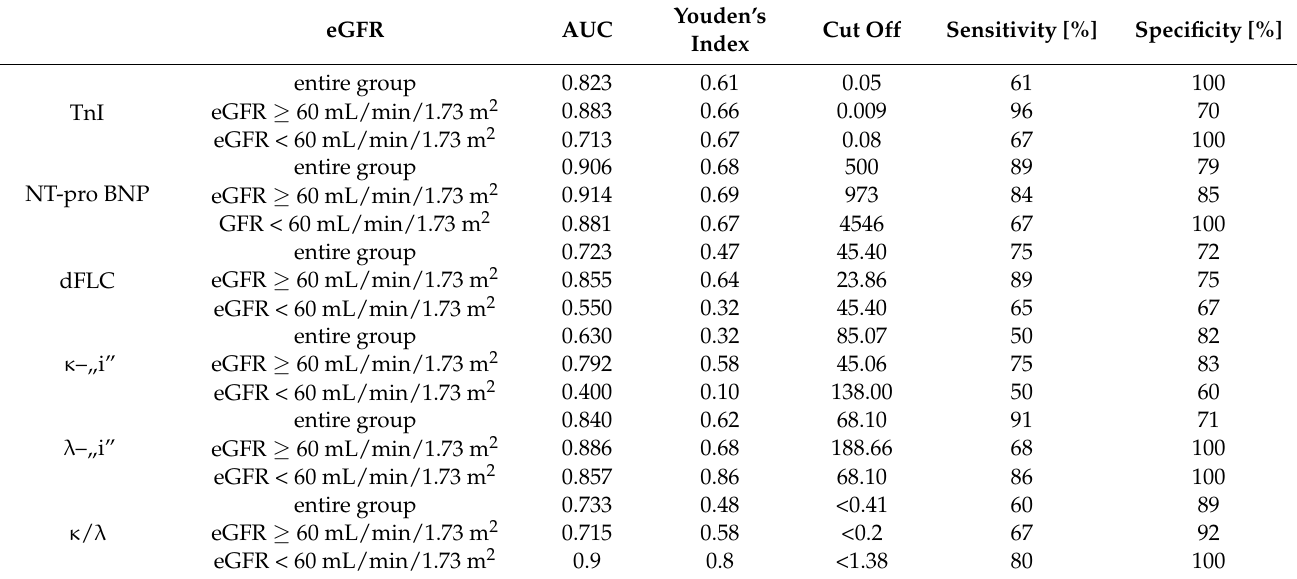
Table 4. Results of the ROC curves analysis for the concentration of TnI, NT-proBNP, and dFLC values in the diagnostics of myocardial involvement depending on the eGFR